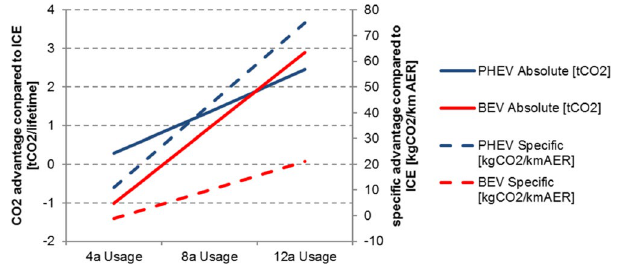
Figure 4. Lifecycle advantages of CO 2eq emissions from PHEV and BEV compared to conventional vehicles on an absolute scale and relative to battery